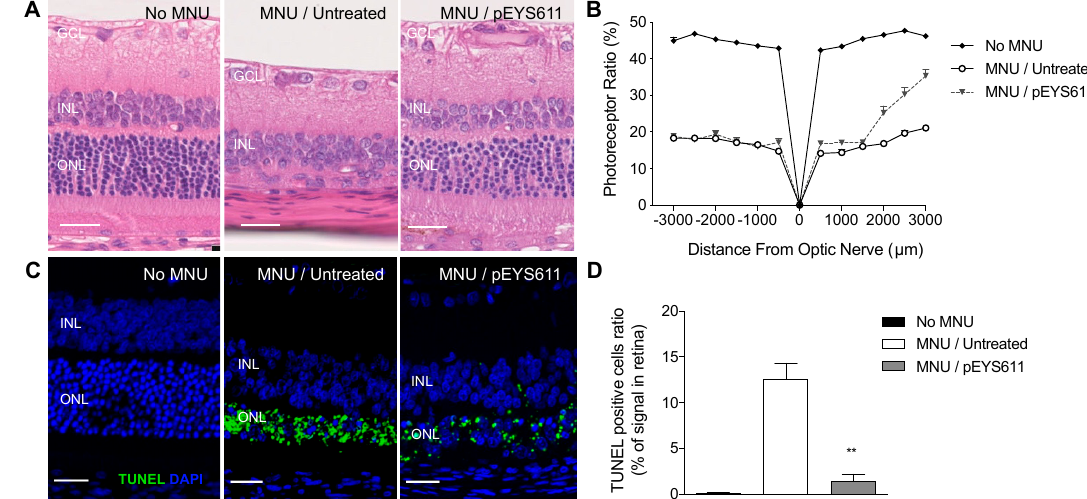
Figure 8. pEYS611 prevents photoreceptors from N-methyl-N-nitrosourea (MNU)-induced cell death in rats. Rats received bilateral ciliary muscle electrotransfection of pEYS611 at the dose 30 µg/eye on D-3 or left untreated ( n = 8 animals/group). Except for not intoxicated rats (no MNU; n = 3 animals), retinal degeneration was induced by intraperitoneal injection of MNU (60 mg/kg) on D0. Histological analyses were performed on D3 and D8. ( A ) Representative images of the hematoxylin eosin-stained retinal sagittal section at D8. Images were performed at a distance of 2000–2500 µm from the optic nerve. ( B ) Outer retinal thickness and total retinal thickness were measured every 500 µm from the optic nerve (0) to the inferior ( − ) and superior (+) poles of the retina. The photoreceptor ratio was calculated as (outer retinal thickness/total retinal thickness) × 100. ( C ) Representative images of TUNEL staining on the retinal section (superior pole) performed on D3. ( D ) TUNEL immunostaining is presented as a percentage of the stained surface area over the entire retina. All values are presented as mean ± sem. ** p < 0.01 using Dunn’s multiple comparisons test versus MNU/untreated group. Scale bar, 25 µm. INL, inner nuclear layer; GCL, ganglion cell layer; ONL: outer nuclear layer.